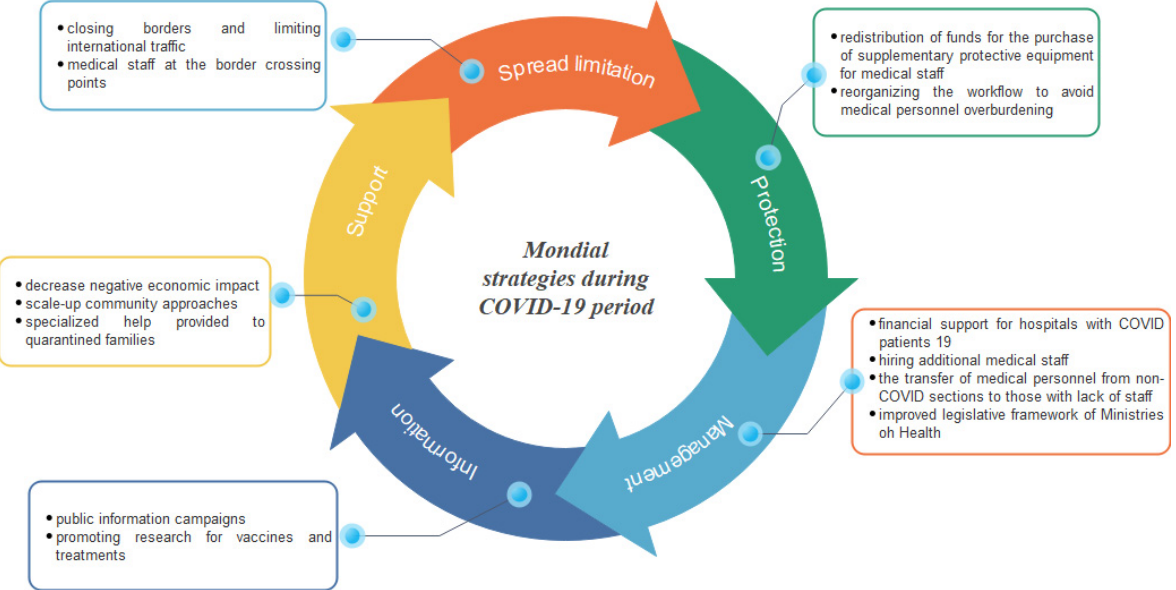
Figure 1. Mondial strategies during C19, describing five measures that focus on redesigning public health care systems to better manage future pandemic events.